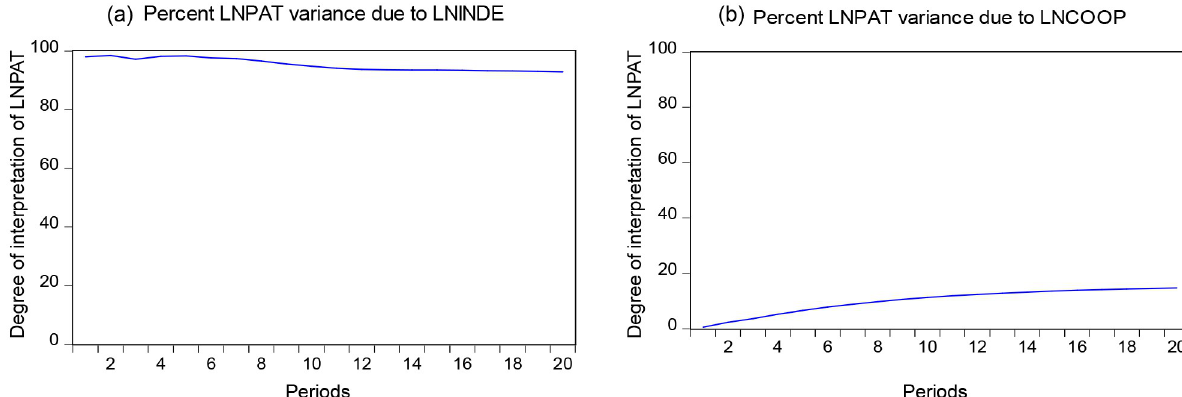
Fig 4. Variance decompositions results of LNINDE, LNCOOP on LNPAT.